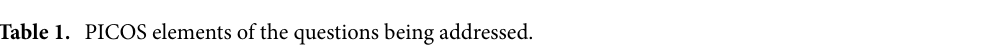
Table 1. PICOS elements of the questions being